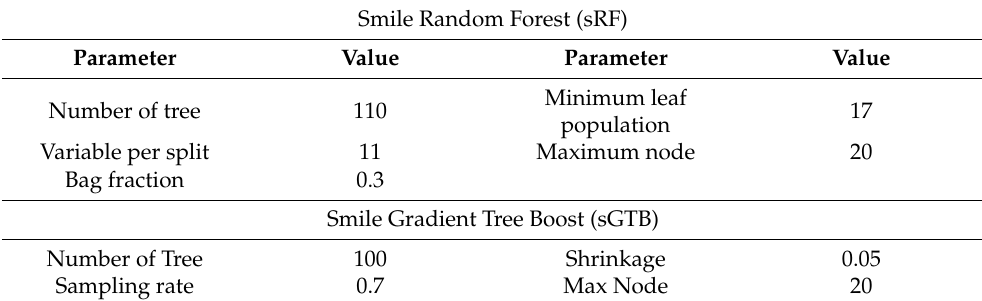
Table 3. sRF and sGTB hyper-parameters used in the